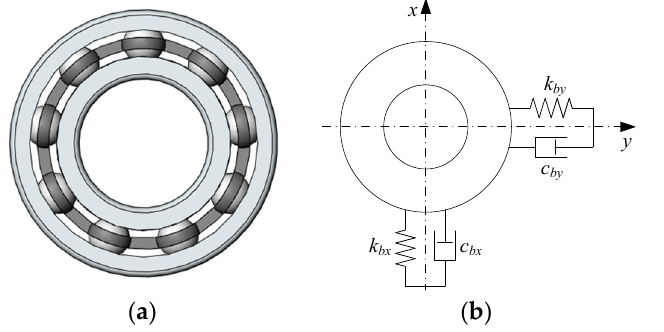
Figure 8. Rolling bearing unit. ( a ) Rolling bearing; ( b ) equivalent spring-damping model.